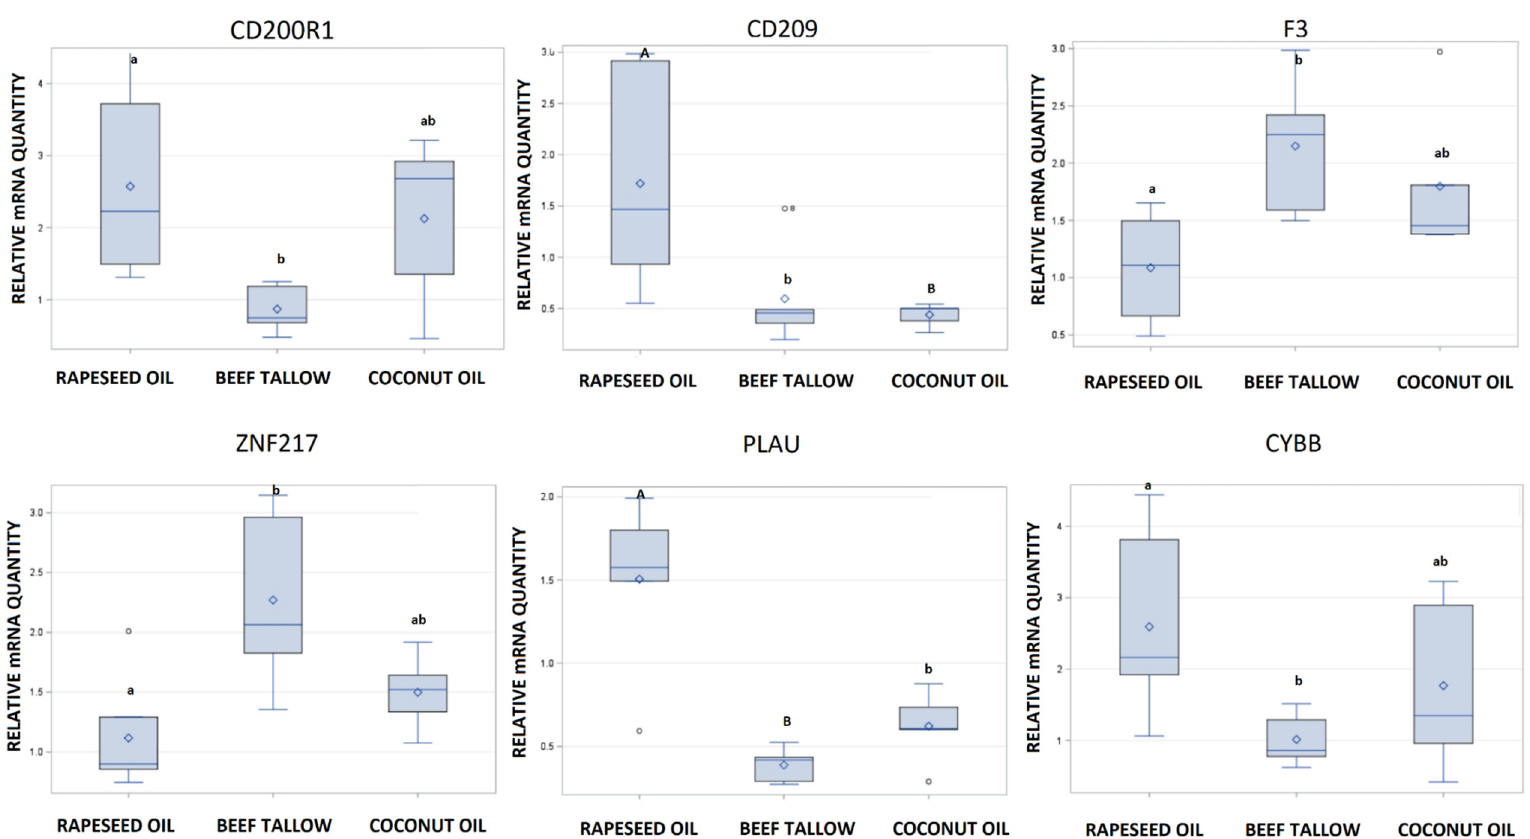
Figure 7. Validation of RNA-seq experiment by qPCR. Error bar-SD. Different letters shows significant differences among groups (small letters: a, b, p < 0.05, capital letters: A, B, p < 0.01).